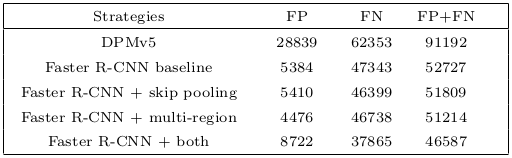
Table from the paper: POI: Multiple Object Tracking with High Performance Detection and Appearance Feature
Table text:
Strategies
FP
FN
FP+FN
DPMv5
28839
62353
91192
FasterR-CNNbaseline
5384
47343
52727
FasterR-CNN+skippooling
5410
46399
51809
FasterR-CNN+multi-region
4476
46738
51214
FasterR-CNN+both
8722
37865
46587